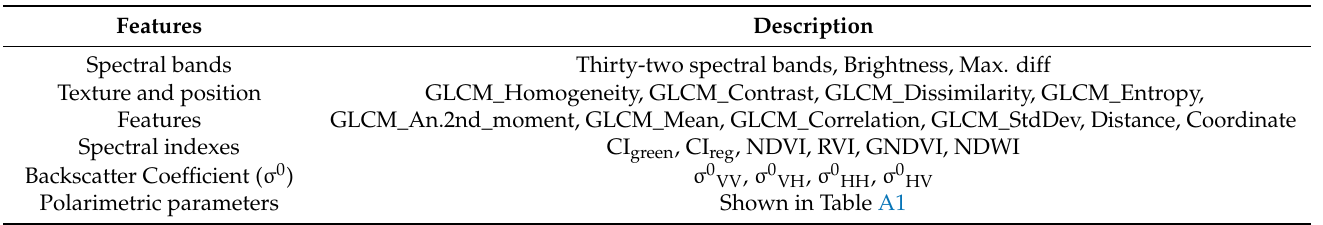
Table A2. Description of the multi-dimensional